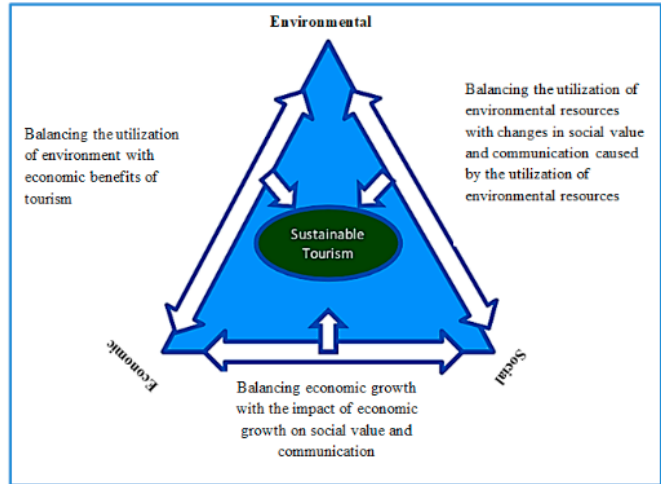
Figure 12. Sustainable Tourism achieved through Balancing Environmental, Economic and Social Aspects. [36]. Aspects.